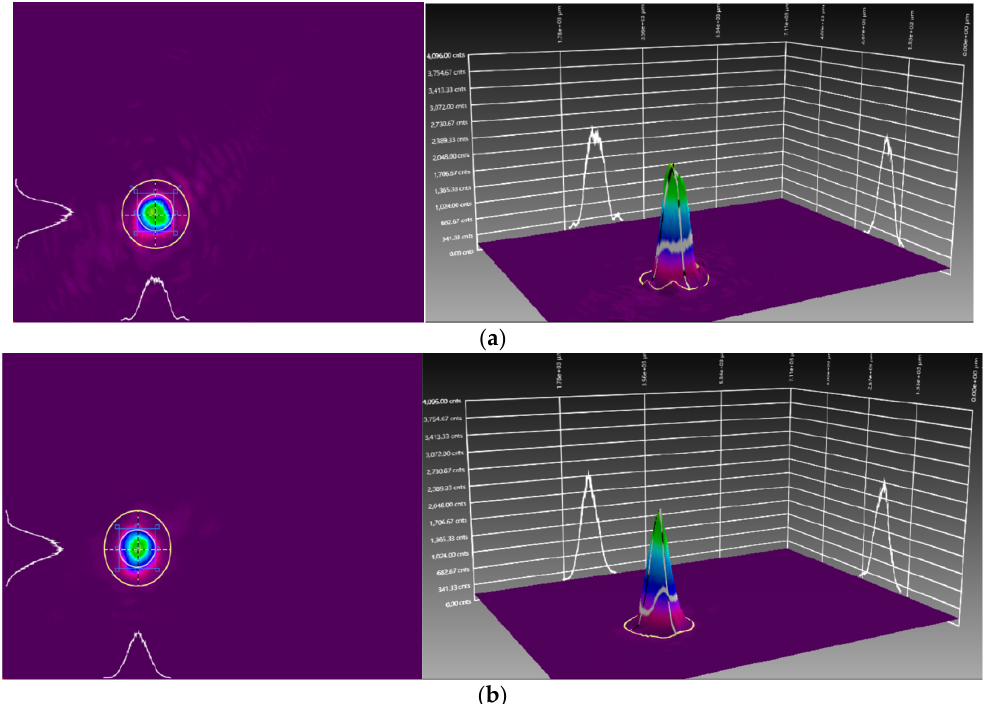
Figure 5. 2D and 3D diffraction patterns of ( a ) DG-gel and ( b ) DG-gel-Br using a laser beam system.